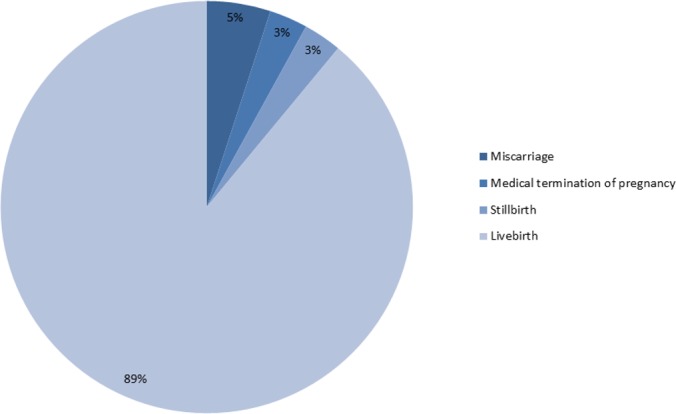
Pregnancy outcomes.